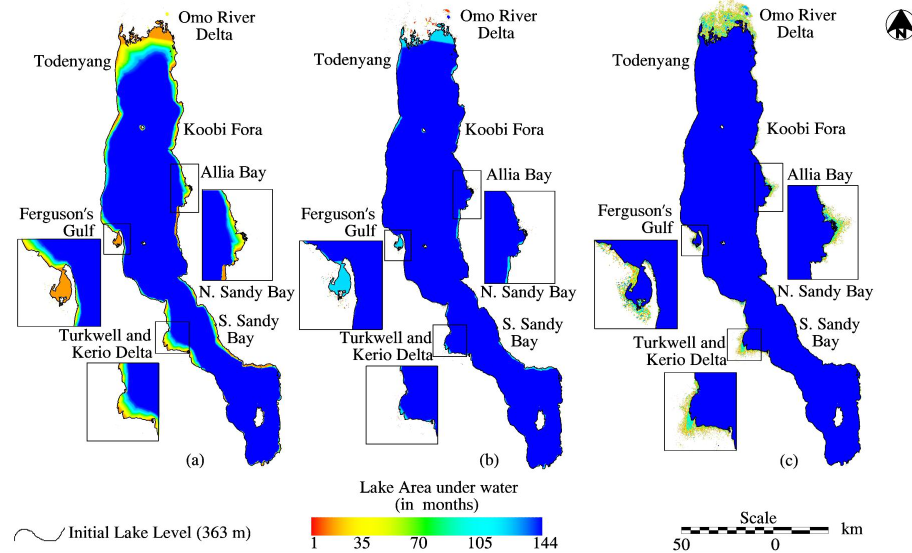
Fig. 8. Simulation of the impact of the Gibe III dam on Lake Turkana shoreline changes under three potential scenarios: (a) below normal rainfall scenario (lower 95% confidence interval) – the lake shoreline would shrink up to 4m inwards from the initial lake level; (b) near normal rainfall scenario (median) – the lake shoreline would not show much variability from the initial lake level; (c) above normal rainfall scenario (upper 95% confidence interval) – the lake shoreline would grow outwards from the initial lake level, flooding several regions along the shoreline. The color denotes the time in months the lake is under